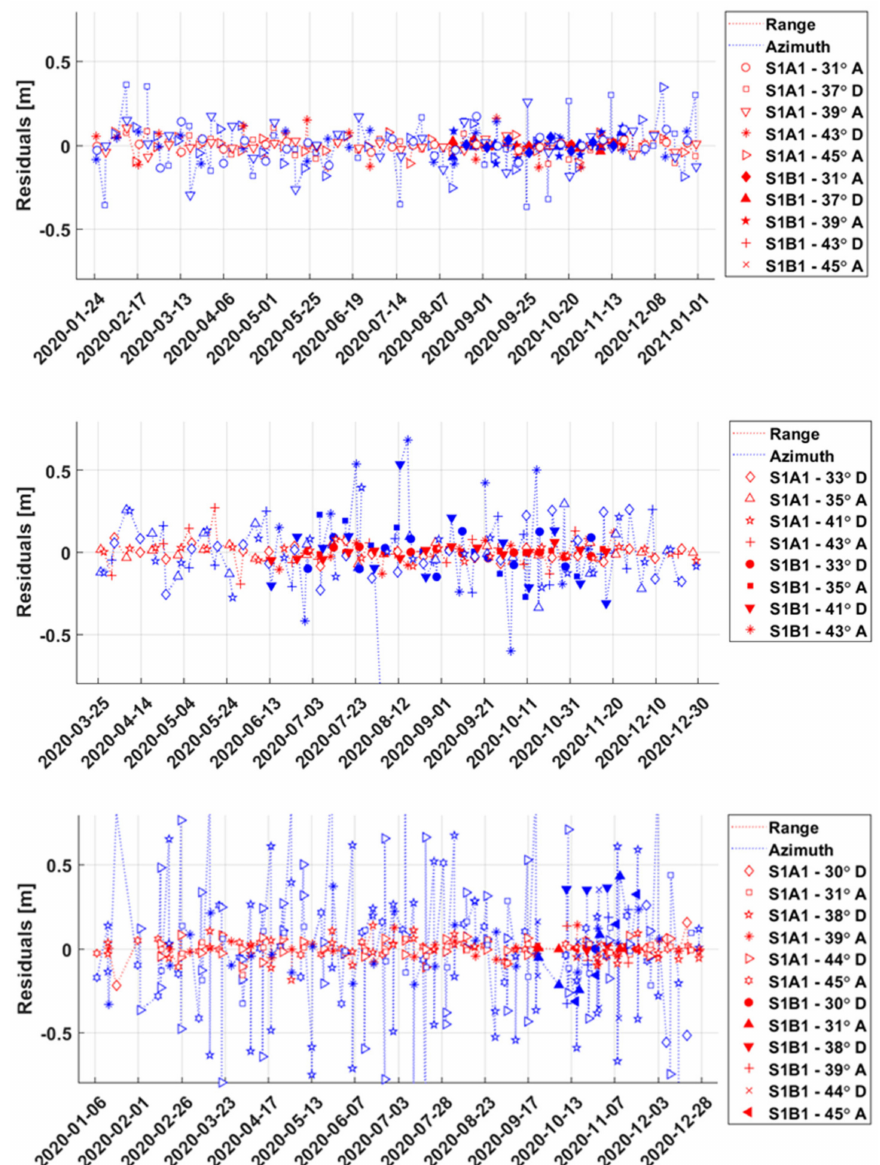
Figure 6. Observation residuals at selected stations. Range observations are colored in red; the different symbols indicate different incidence angles. Azimuth observations are shown in blue; symbols indicate the same incidence angles as for the range observations. Top row: Emäsalo, Finland; Mid row: Władysławowo, Poland; Bottom row: Mårtsbo,